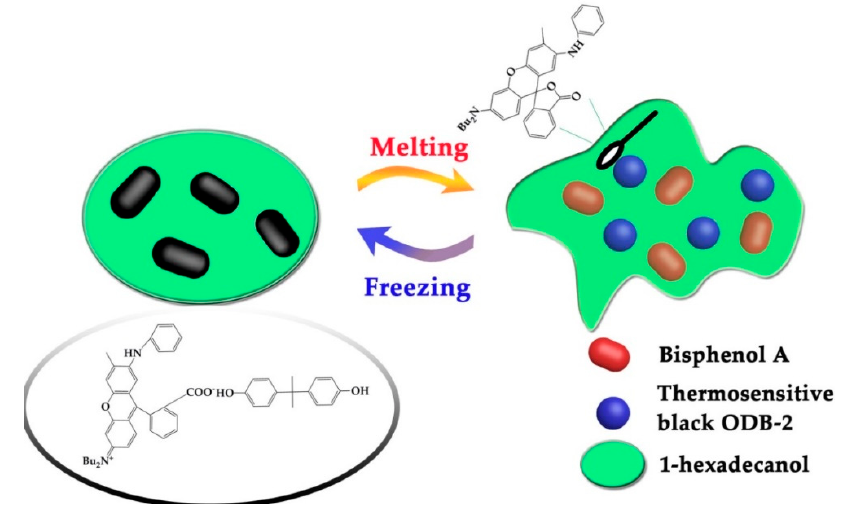
Figure 1. Diagram of the thermochromic process.